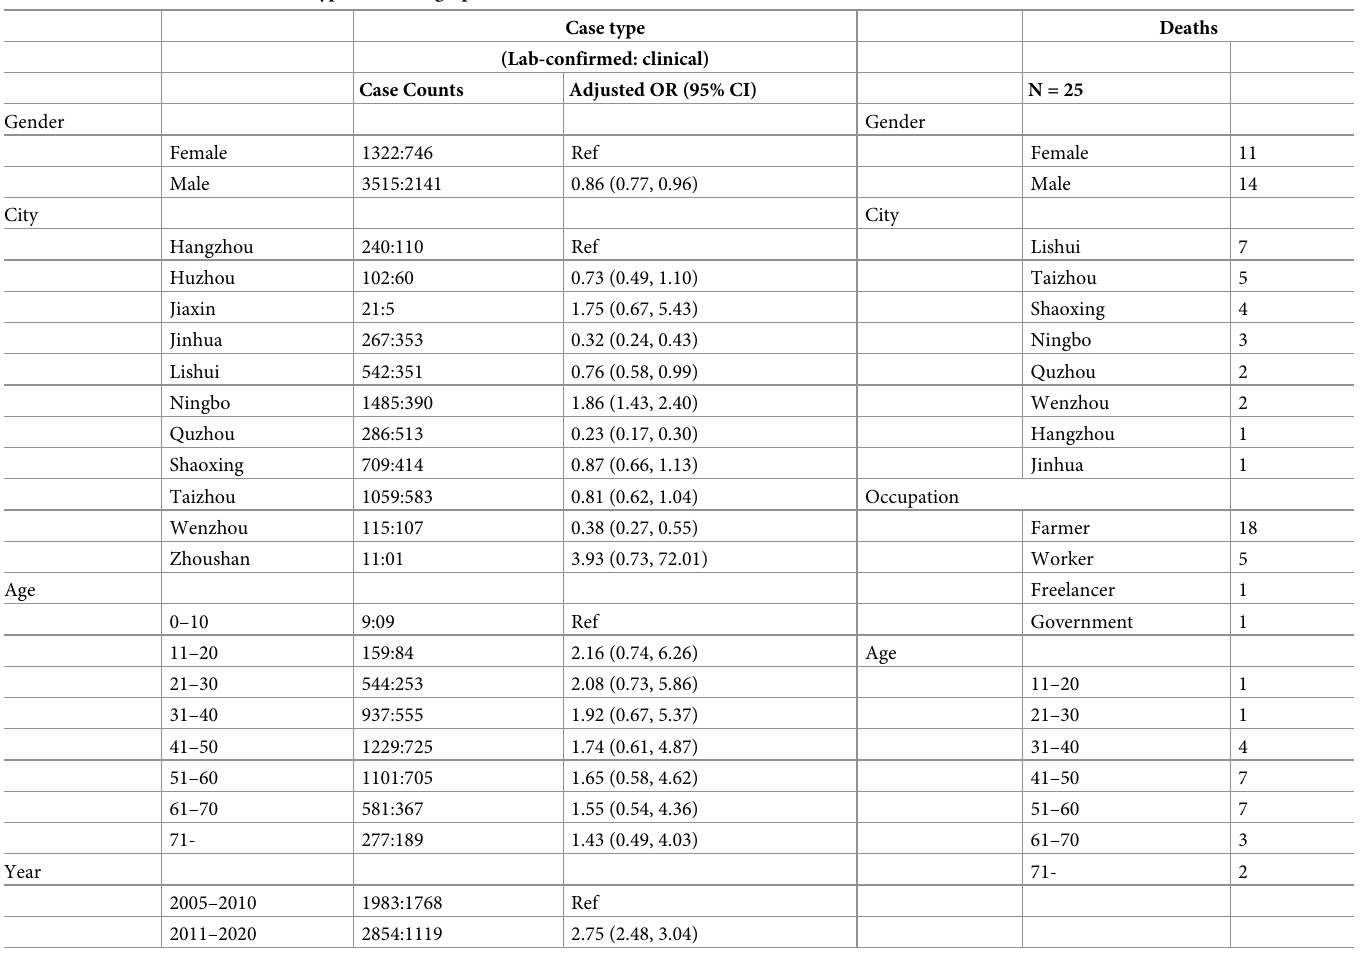
Table 1. Factors associated with case type and demographic information about death cases,